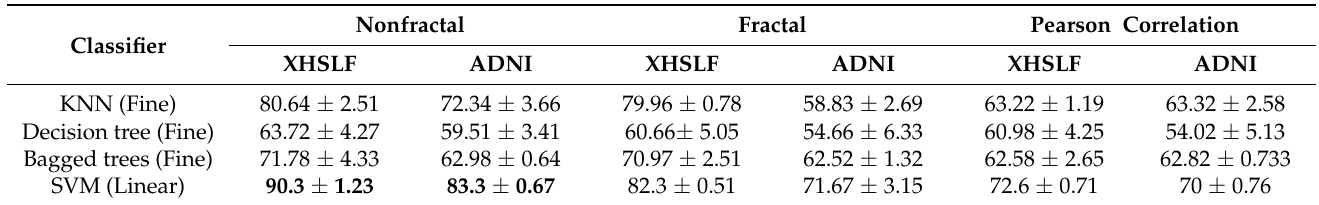
Table 3. Ten-fold cross-validation classification accuracy (in %) of AD vs. NC using k-nearest neighbor (KNN), decision tree, bagged trees and SVM for XHSLF and ADNI dataset.